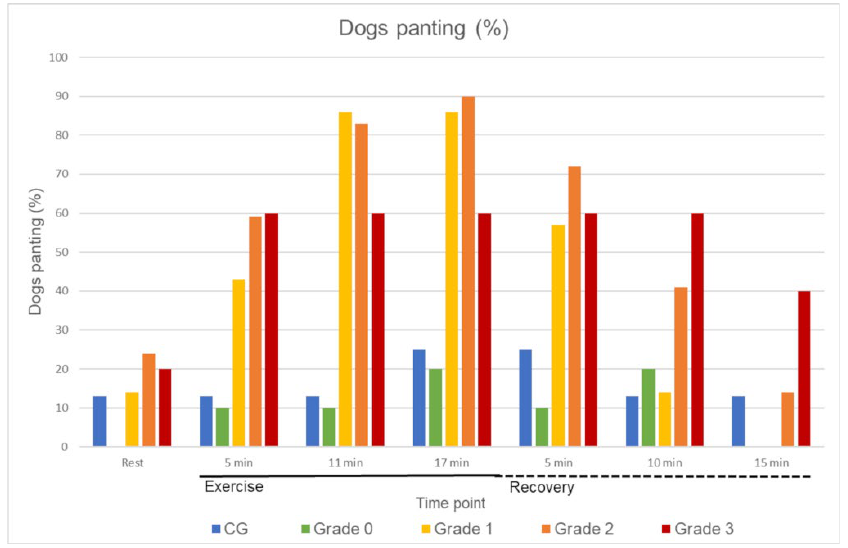
Figure 3. Percentage (%) of panting dogs in the control group (CG) and pugs divided into BOAS grades 0–3. Table 7. Number of pugs (total and divided into BOAS grades 0–3) and dogs in the control group (CG) that recovered in ≤5, ≤10, ≤15 min or >15 min in terms of heart rate (beats per minute (bpm)), body temperature (°C), and respiratory rate.